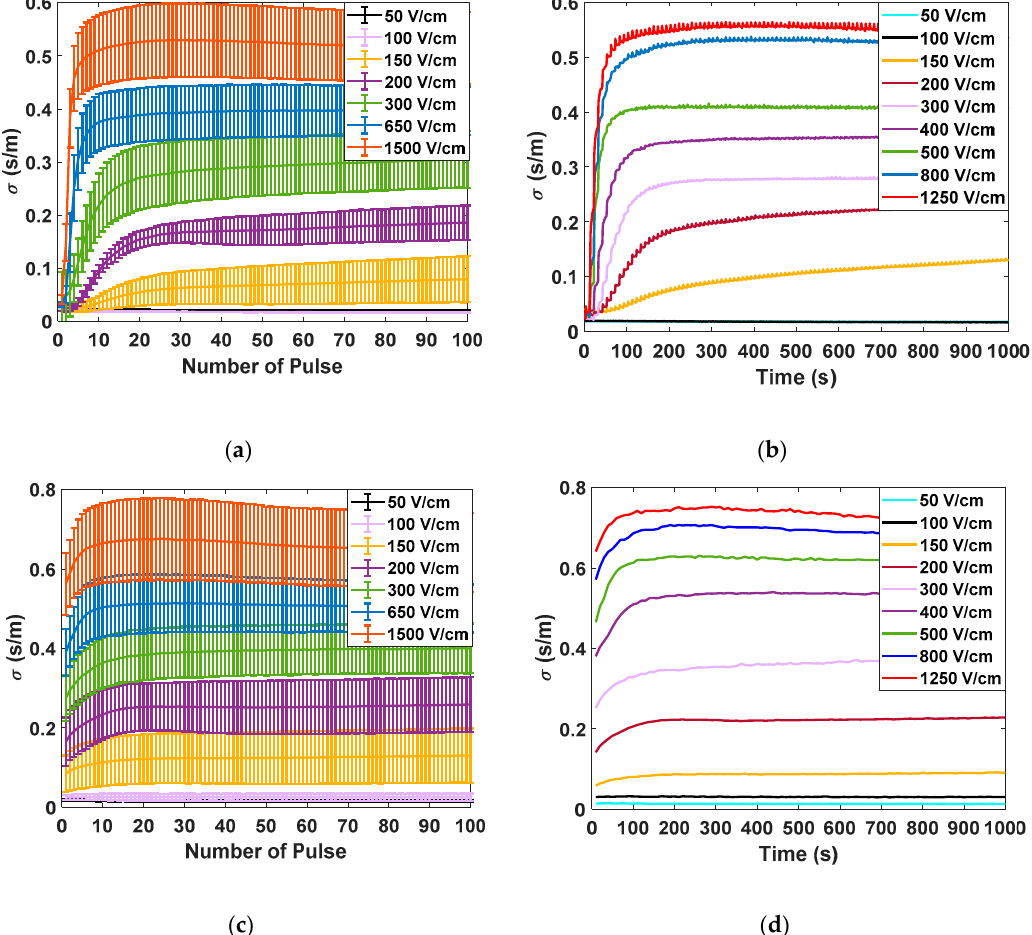
Figure 5. Large-signal and small-signal conductivity measurements for di ff erent electric field intensities: ( a ) average and typical deviation of small-signal conductivity measured 10 ms after the application of each electroporation pulse, taking ten samples per studied electric field; ( b ) small-signal conductivity measurements for nine samples between each large-signal pulse and nine di ff erent electric fields; ( c ) average and typical deviation of large-signal conductivity measured in electroporation pulse for ten samples per studied electric field; and ( d ) large-signal conductivity measurements for nine di ff erent electric fields.